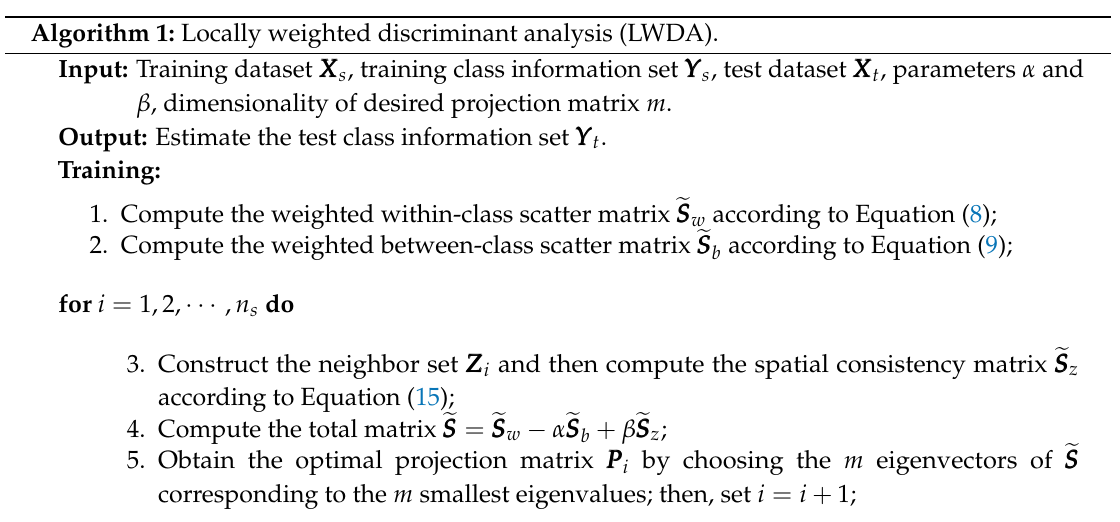
Algorithm 1: Locally weighted discriminant analysis